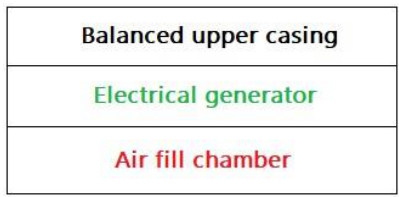
Figure 9. Block diagram of a total wave energy converter with casing.